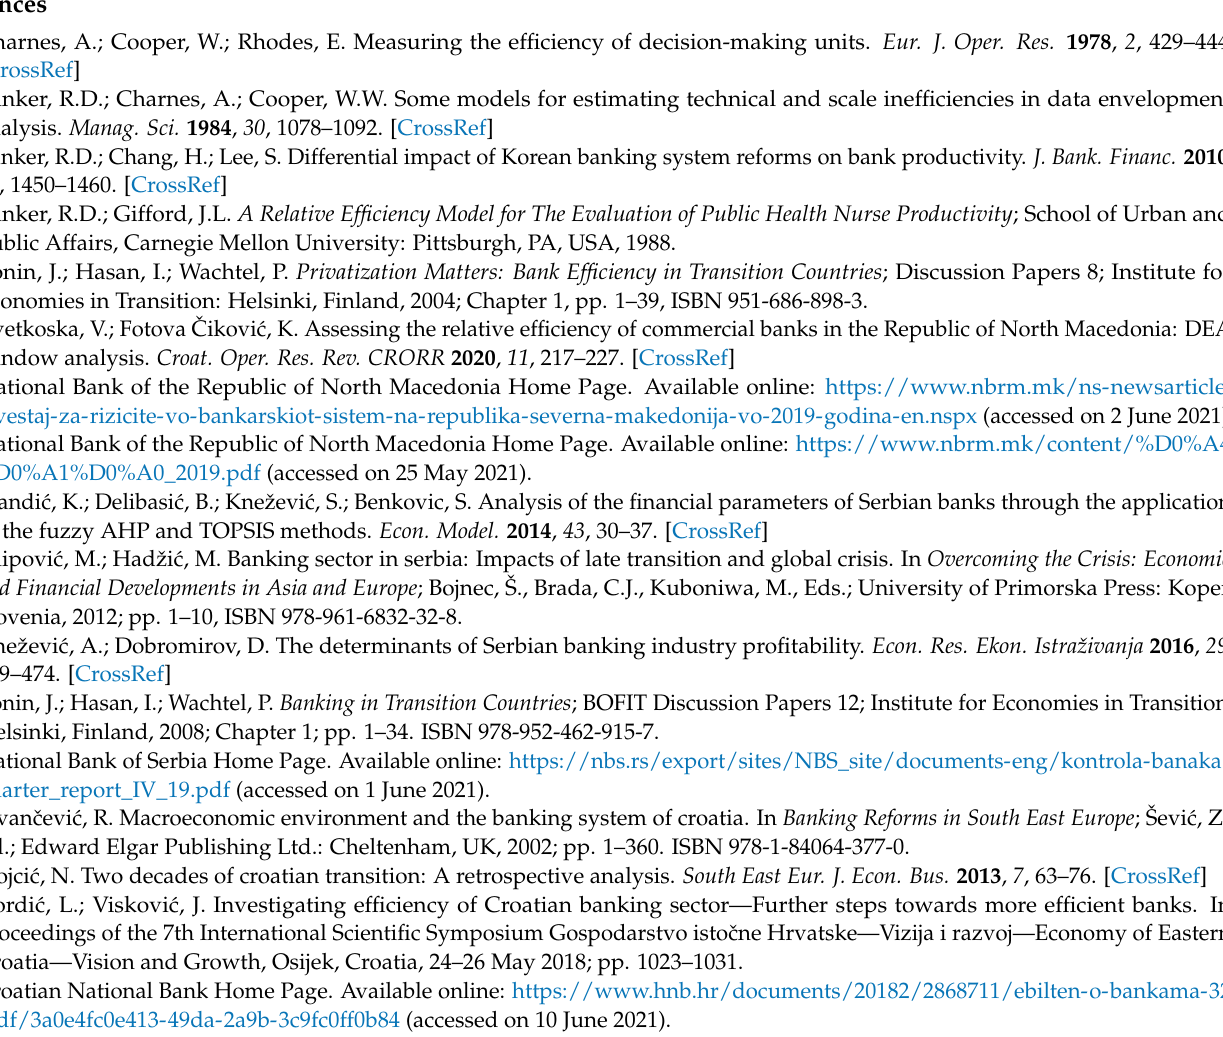
Figure A9. Mean for the outputs for each bank.